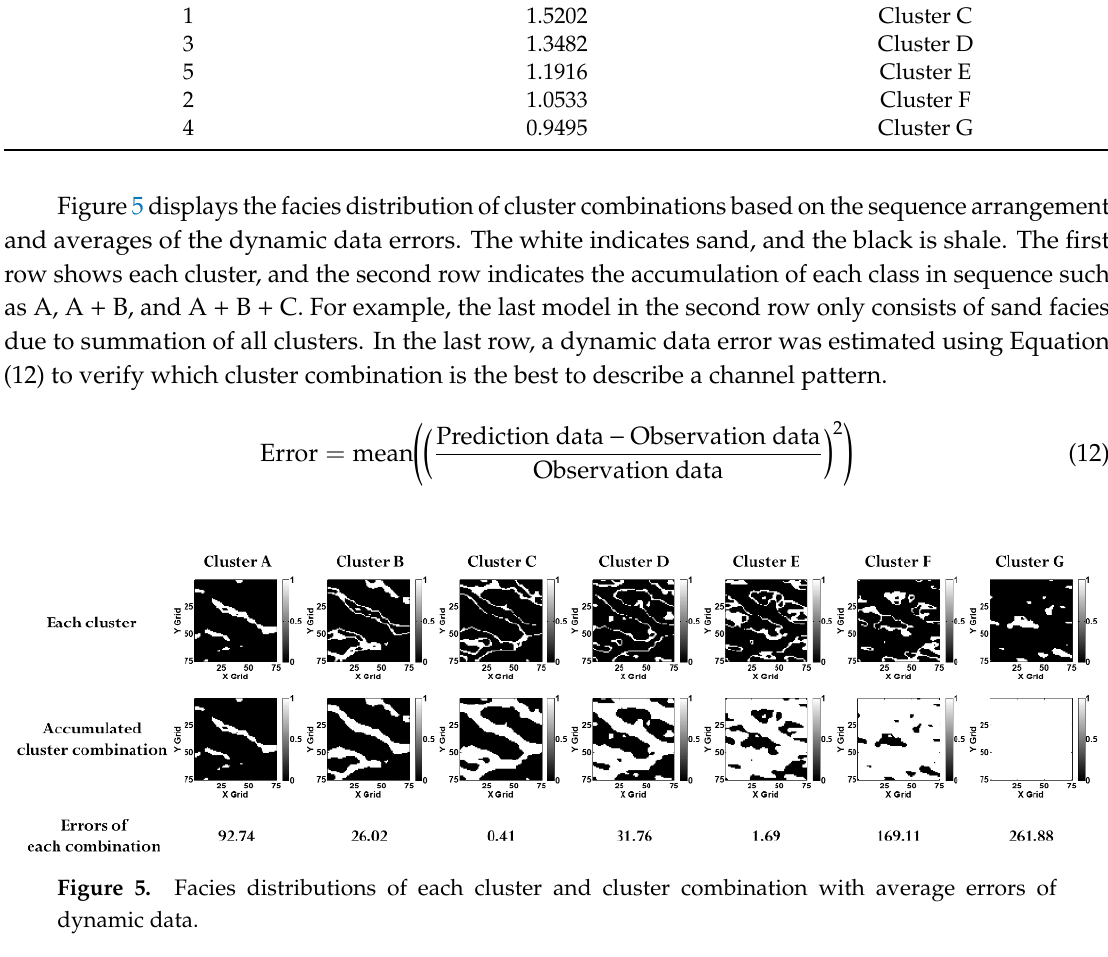
Figure 6. Example of overall update procedures of a channel reservoir using DCT.